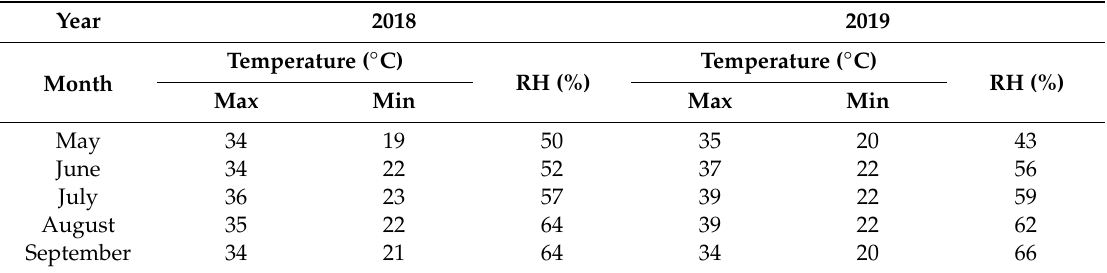
Table 1. Meteorological data for the two summer growing seasons 2018 and 2019.